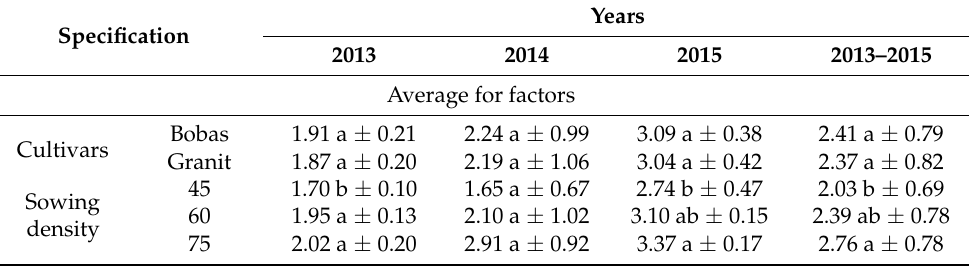
Table 3. The effect of the examined factors on straw yields (t ha − 1 ) in the years of research 2013–2015.